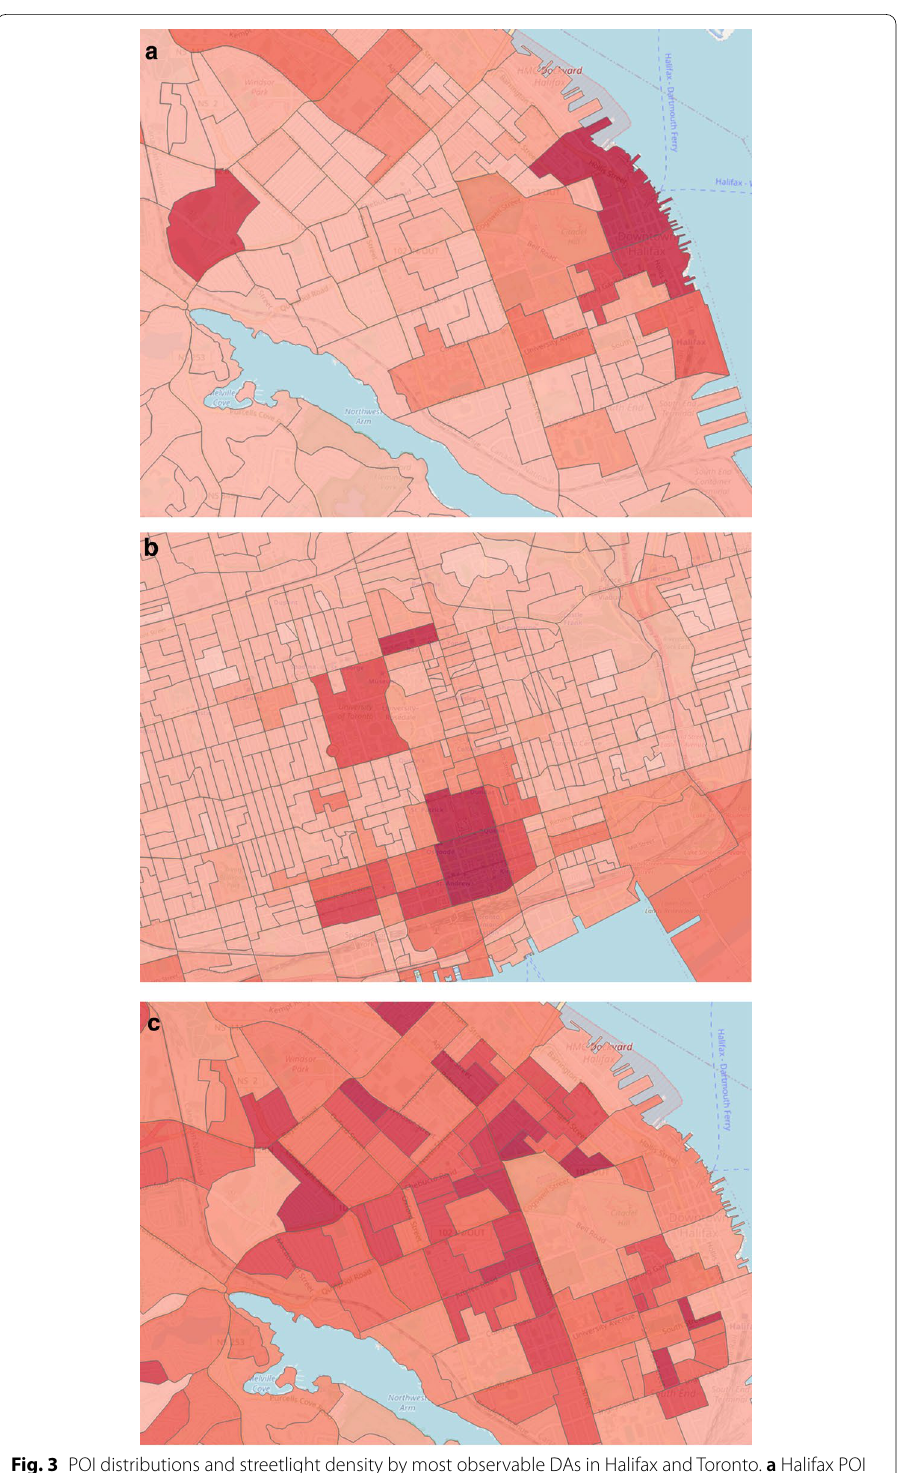
Fig. 3 POI distributions and streetlight density by most observable DAs in Halifax and Toronto. a Halifax POI distribution, b Toronto POI distribution, c Halifax streetlight